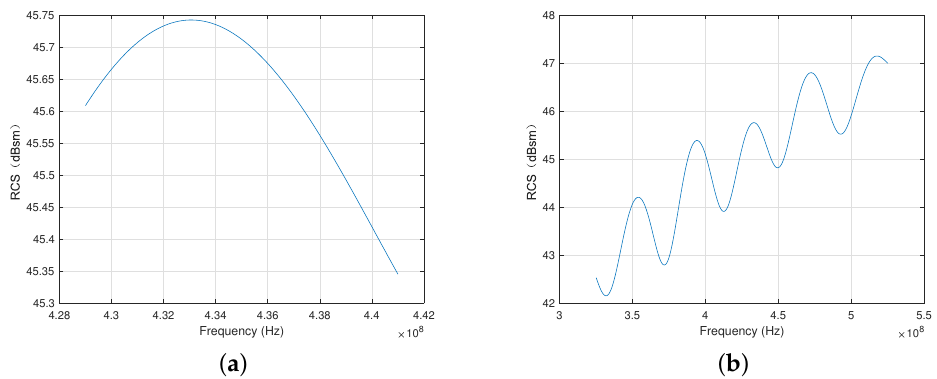
Figure 4. The range RCS pattern of the parabolic antenna. ( a ) Range RCS Pattern with Bandwidth = 6 MHz; ( b ) range RCS Pattern with Bandwidth = 100